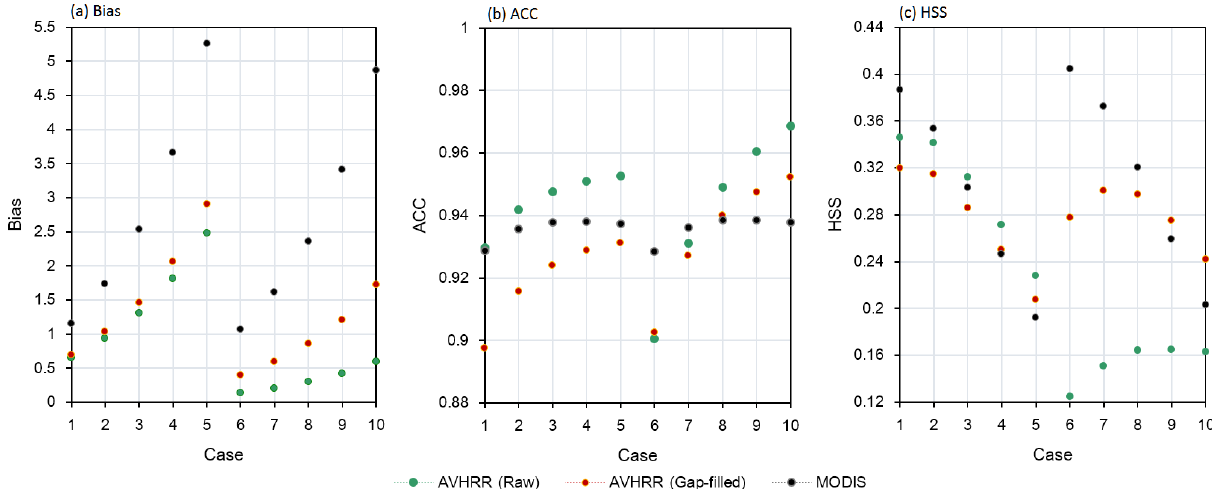
Figure 3. Sensitivity analysis of product accuracy related to snow depth thresholds of the in situ station data. The overall error is a spatiotem- porally integrated statistical measure.